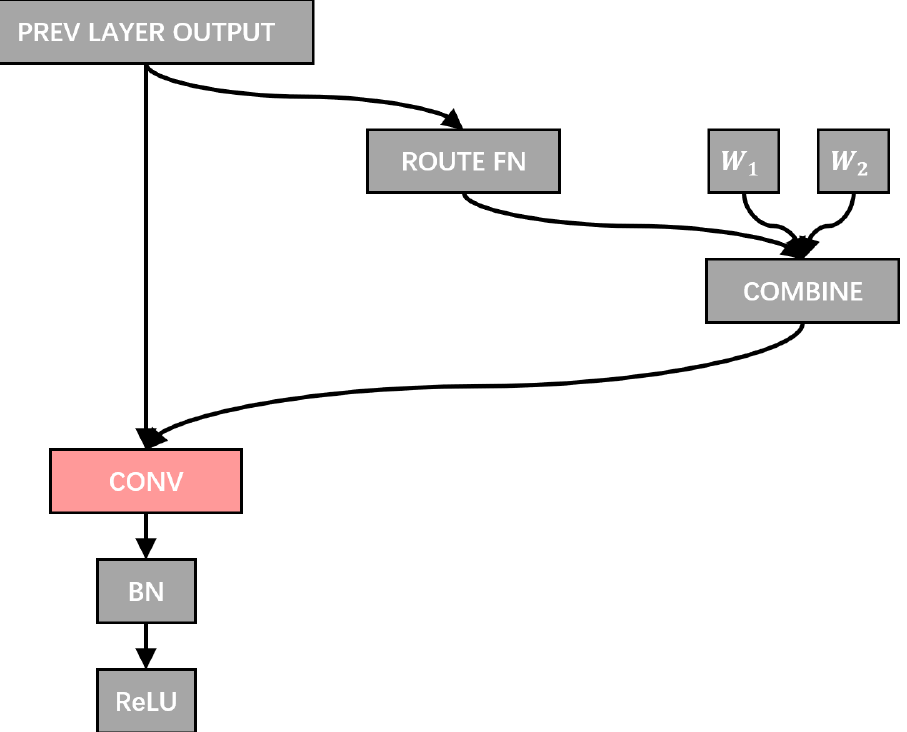
Figure 6. CondConv [78] layer architecture with n = 2 kernels. CondConv: ( α 1 W 1 + α 2 W 2 ) × x